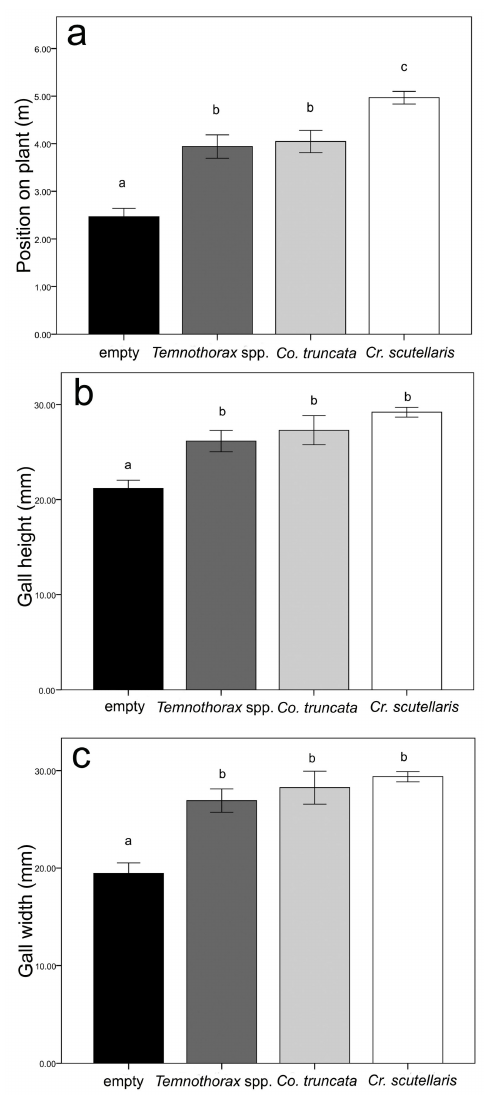
Figure 3. Graphs showing gall preferences of the di ff erent ant species according to the data collected in Experiment 1. The gall preferences are measured as gall position on the plant ( a ), gall height ( b ), and gall width ( c ). The SE interval is shown for each bar. The bars with the same letter are not statistically di ff erent (One-way ANOVA, see text for further